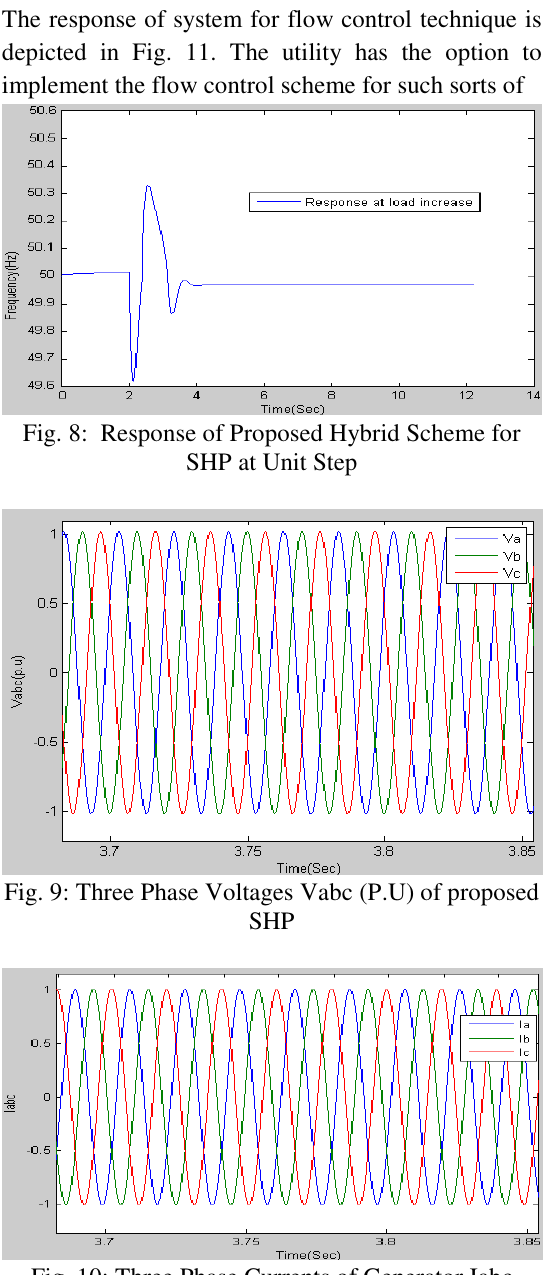
Fig. 10: Three Phase Currents of Generator Iabc (P.U) of Proposed SHP